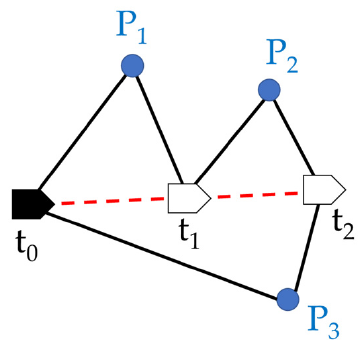
Figure 1. Constraint conditions for bundle adjustment.